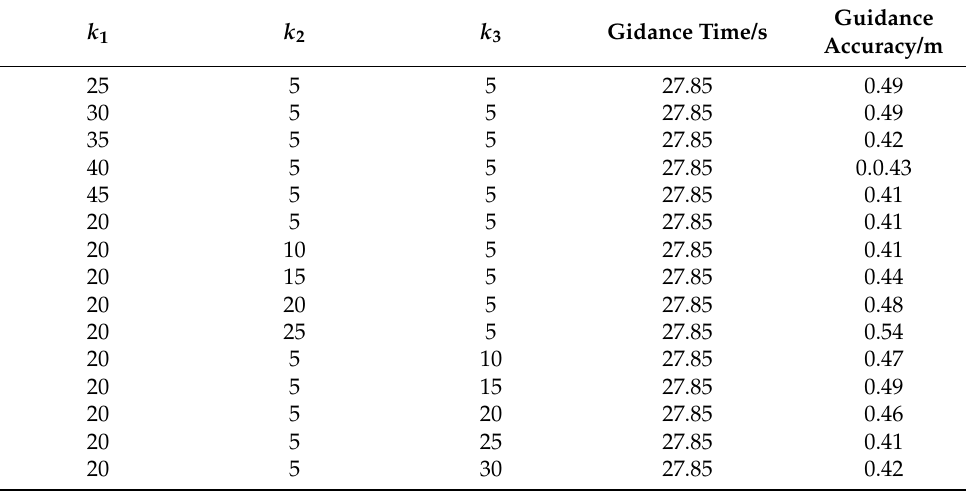
Table 6. Performances of different parameters with square wave